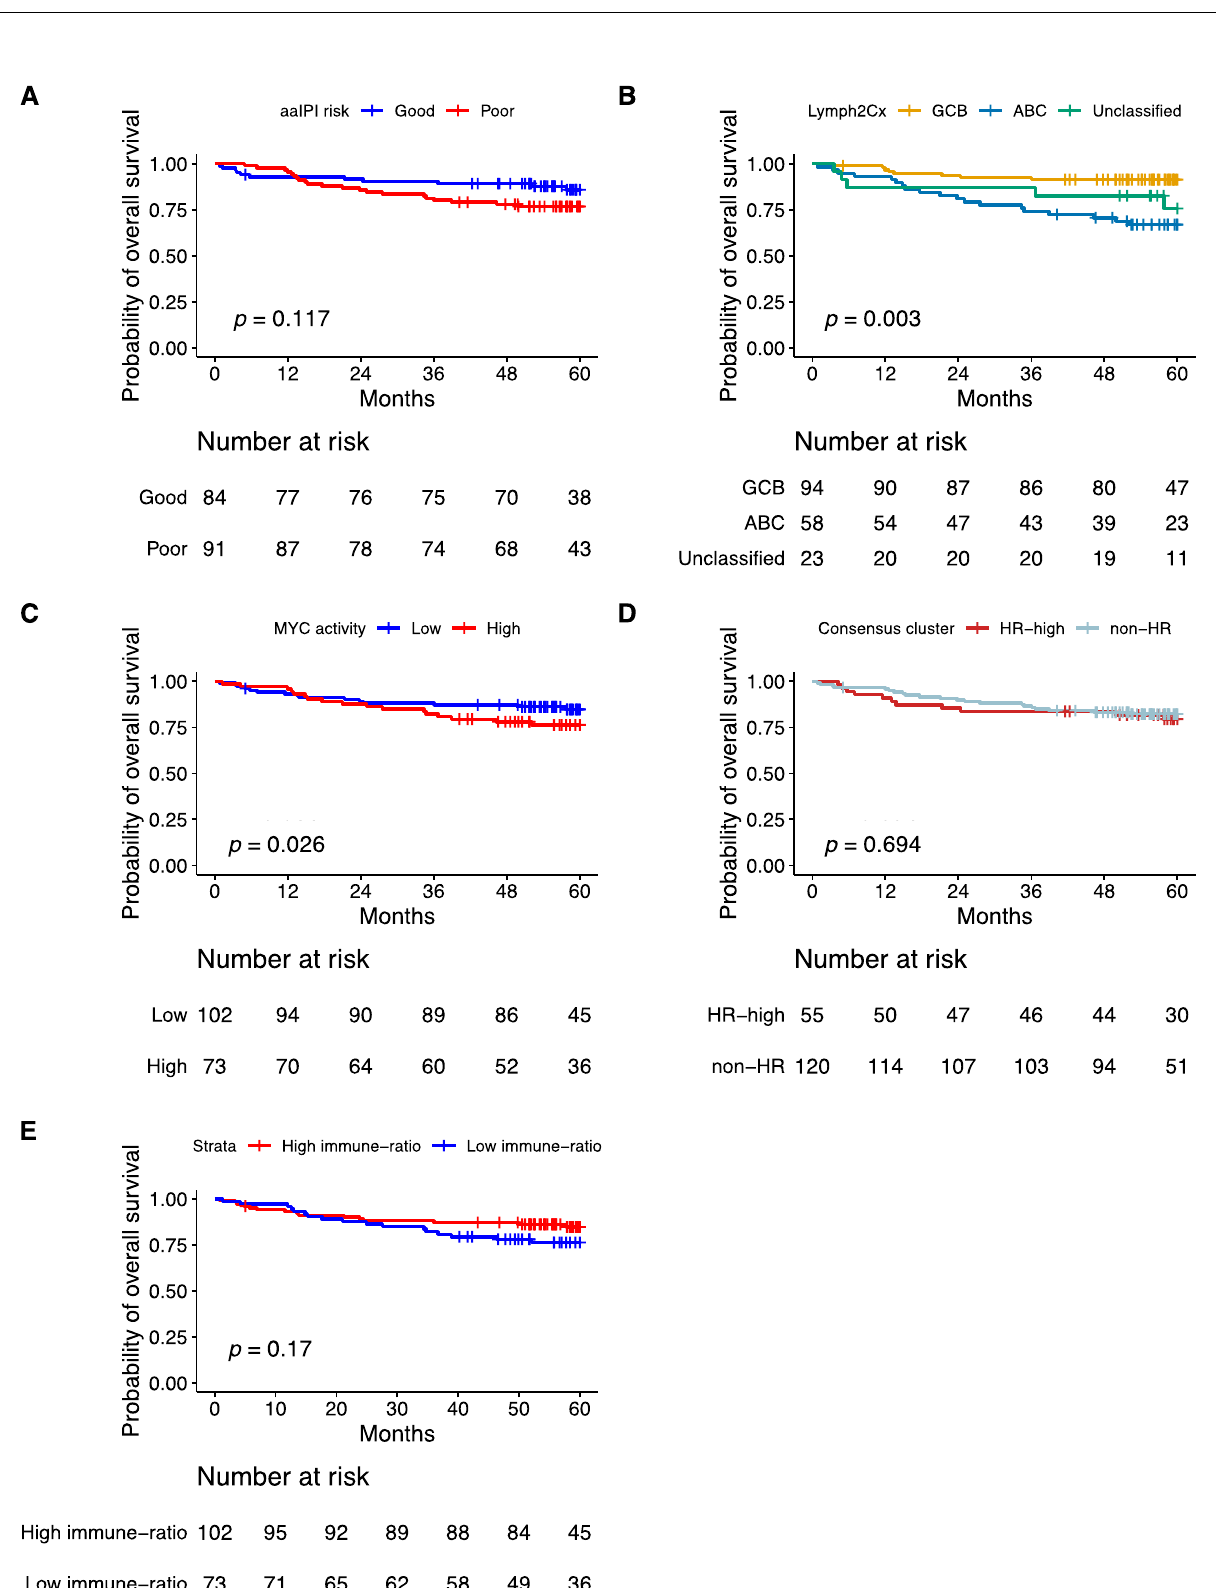
Figure 5. Kaplan–Meier curves showing overall survival of 175 patients from the HOVON-84 cohort: According to ( A ) the aaIPI, ( B ) the COO classification defined by the Lymph2Cx algorithm, ( C ) the Monti consensus clusters, ( D ) the MYC activity classifier, ( E ) the immune-ratio subgroups.